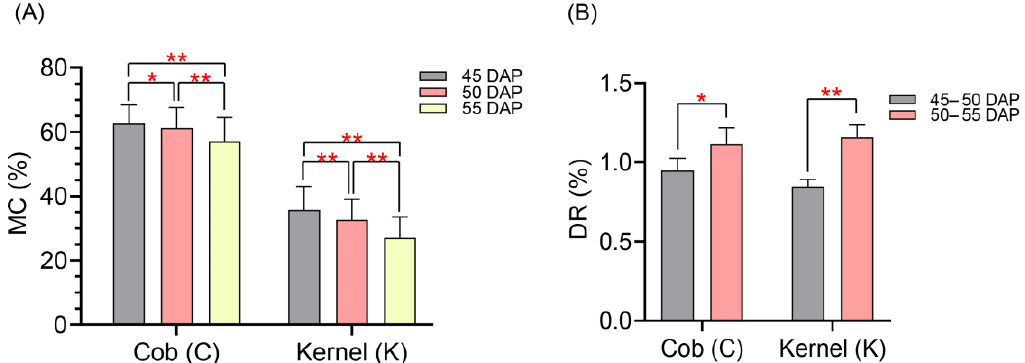
Figure 1. Phenotypes of moisture-content-related traits of the association panel at physiological maturity stages. ( A ) Phenotypic values of CMC and KMC measured at each stage. MC, moisture content. ( B ) Phenotypic values of CDR and KDR measured for the two time spans. DR, dehydration rate. * Significant at p < 0.05. ** Significant at p < 0.01.